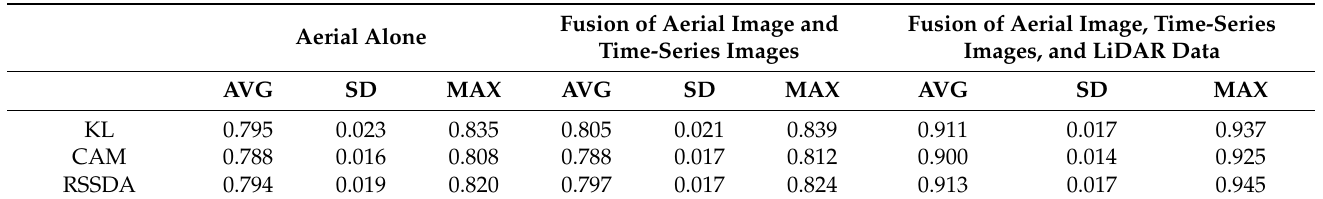
Table 4. The average of overall accuracy for ten performances using the KL, CAM, and RSSDA